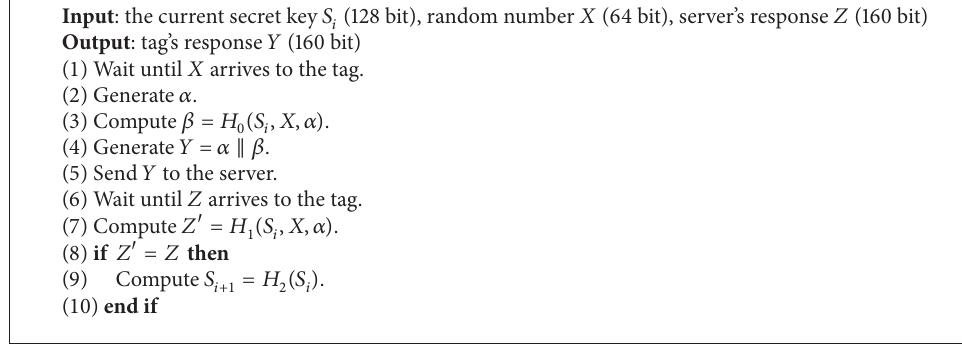
Algorithm 2: Authentication process of the